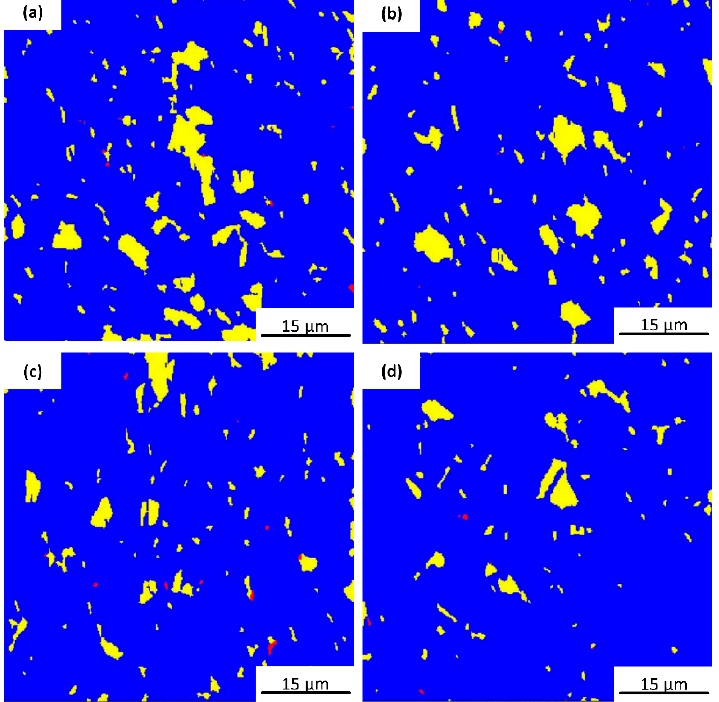
Figure 11. Recrystallization fractions under different annealing times: ( a ) 10 min; ( b ) 30 min; ( c ) 120 min; and ( d ) 240 min.